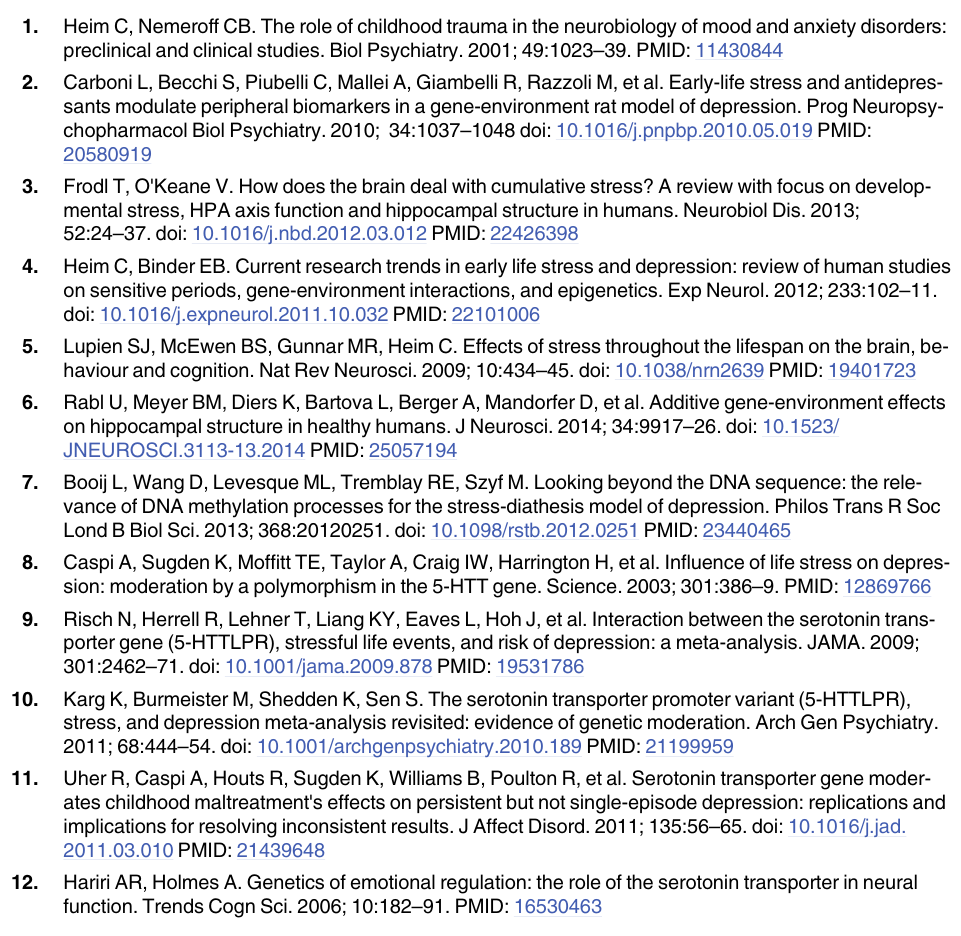
variable. Table B . Parameters of the investigated regression model, including sex, age, MDD di- agnosis, childhood trauma, and hippocampal volume as independent variables, and SLC6A4 methylation (CpG 11&12) as outcome variable. Table C . Parameters of the investigated regres- sion model, including sex, age, MDD diagnosis, childhood trauma, and hippocampal volume of CA2/3 as independent variables, and SLC6A4 methylation as outcome variable. Table D . Pa- rameters of the investigated regression model, including sex, age, MDD diagnosis, childhood trauma, and hippocampal volume (CA4/DG) as independent variables, and SLC6A4 methyla- tion as outcome variable. Table E . Parameters of the investigated regression model, including sex, age, MDD diagnosis, childhood trauma, and hippocampal volume (CA1) as independent variables, and SLC6A4 methylation as outcome variable. Table F . Characteristics by participant. Table G . Characteristics by participant